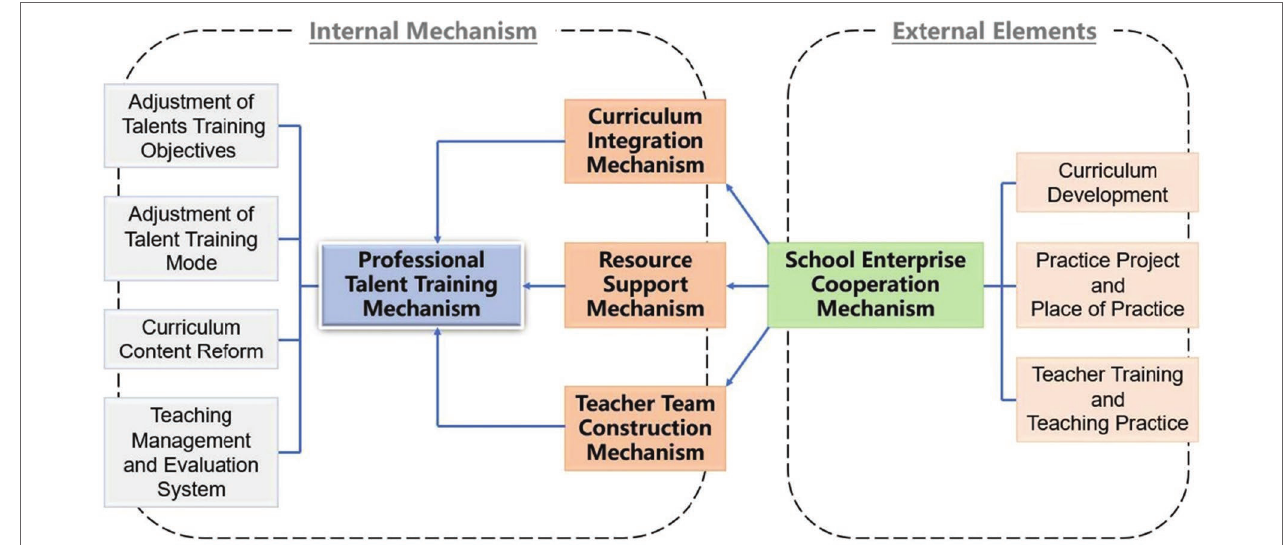
FIGURE 1 | Theoretical